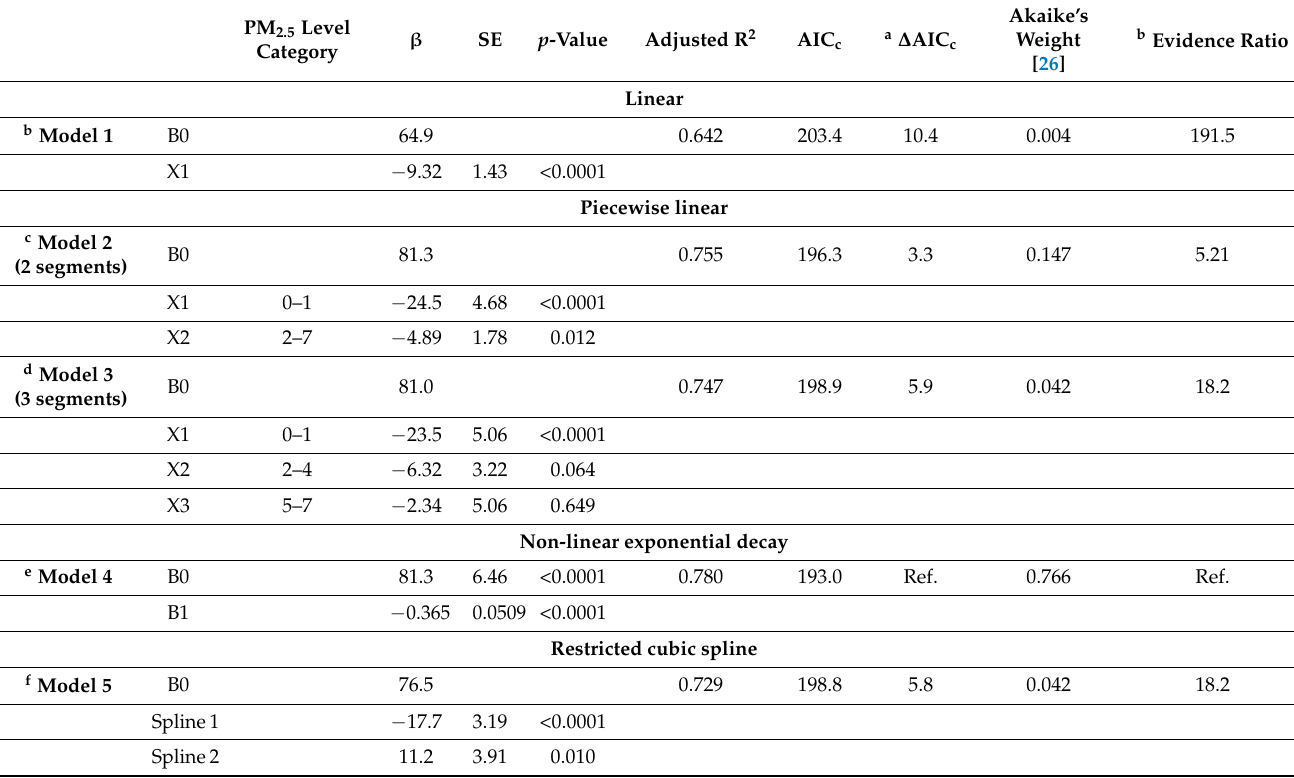
Table 2. Linear and non-linear regression models of the relationship between PM 2.5 level and blood-feeding rate in female Ae. aegypti